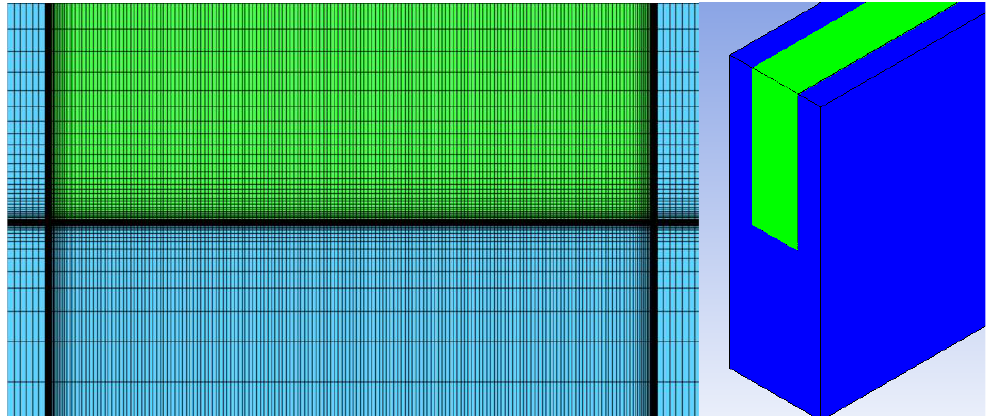
Figure 2. A closeup of the final mesh with first node distance 5 × 10 −7 mm and inflation rate 1.1 .